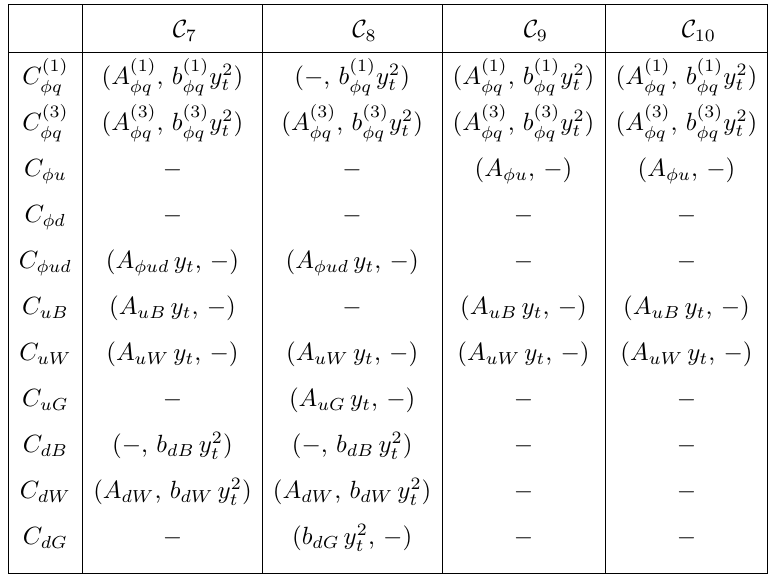
Table 4 . One-loop SMEFT-to-WET matching relations in MFV with up-alignment for operators with two quarks. Shown are the flavor structures of the SMEFT contributions C ( m coefficients C ( m ) . In each entry ( x, y ) , x is the tW loop contribution, and y is from a sZ or bZ Z loop (see text). Effects of O ( m ) or smaller have been neglected, in particular, contributions s /m b to C a 0